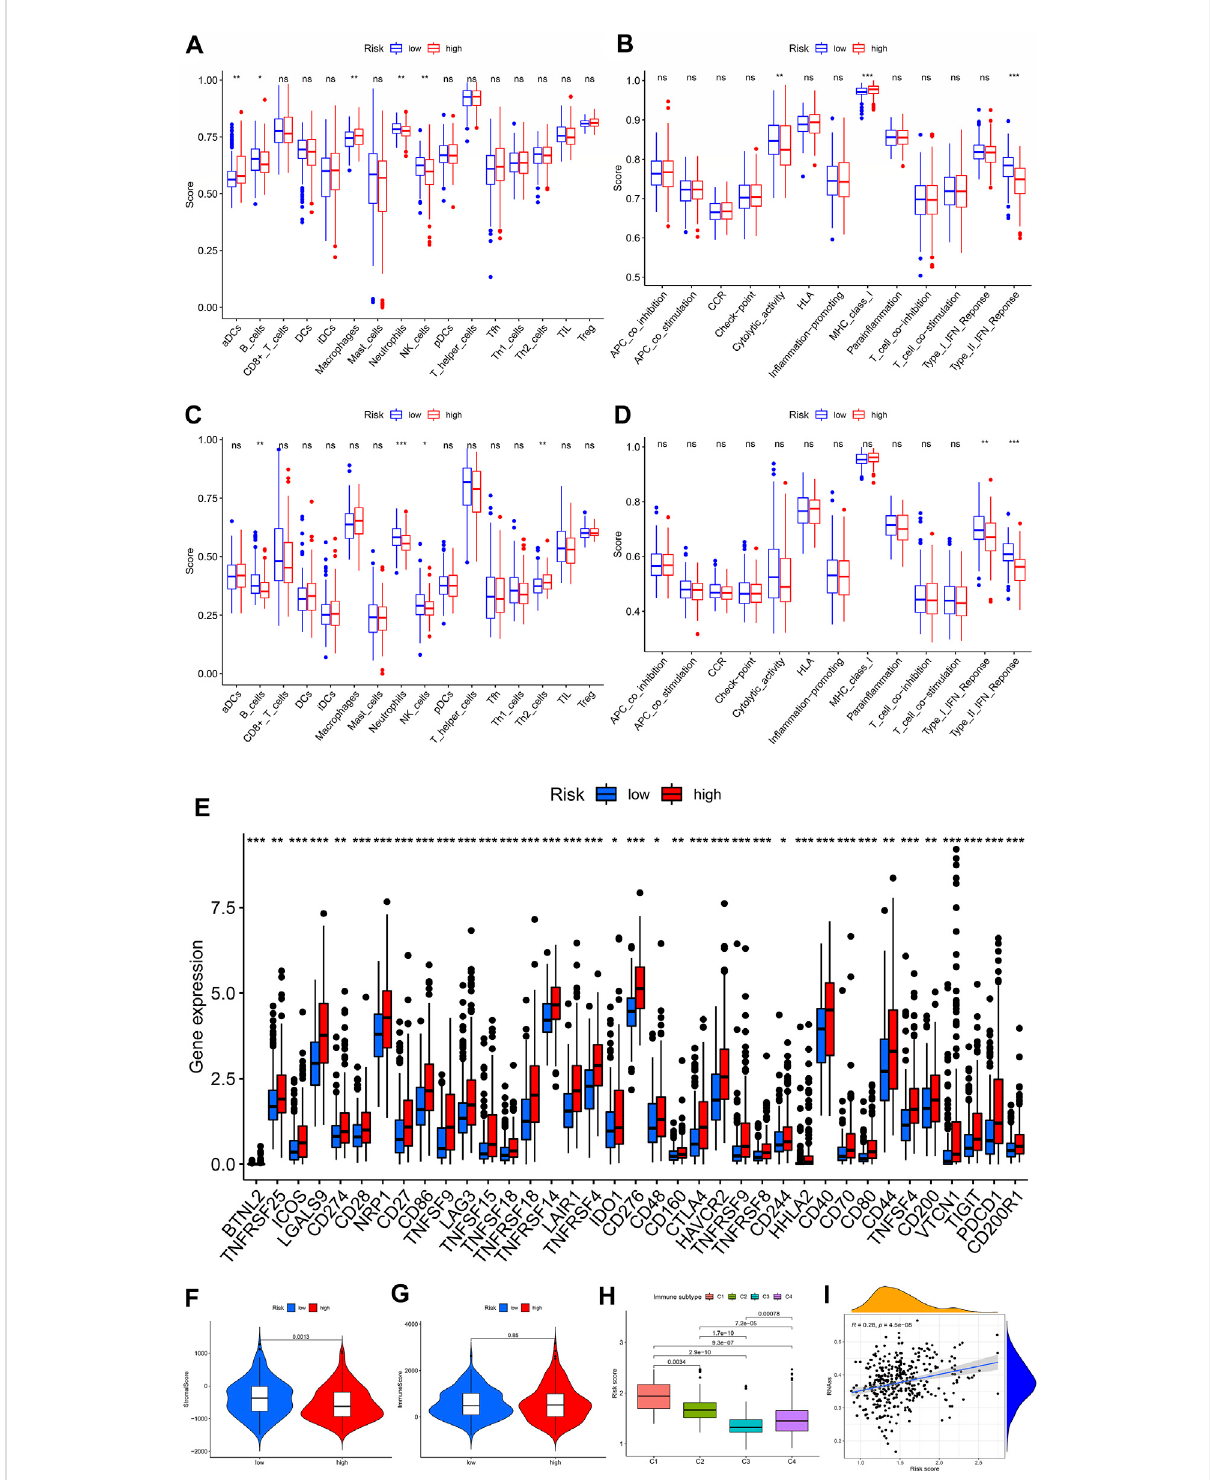
FIGURE 7 Relationship between CRs model and immunity. (A and B) Score of 16 immune cells in the TCGA group and ICGC group. (C and D) Score of 13 immune-related functions in the TCGA group and ICGC group. (E) Expression of immune checkpoints in high- and low-risk groups in TCGA queue. (F and G) Correlation between CRs score and immune and stroma scores. (H) Risk score difference in CMS